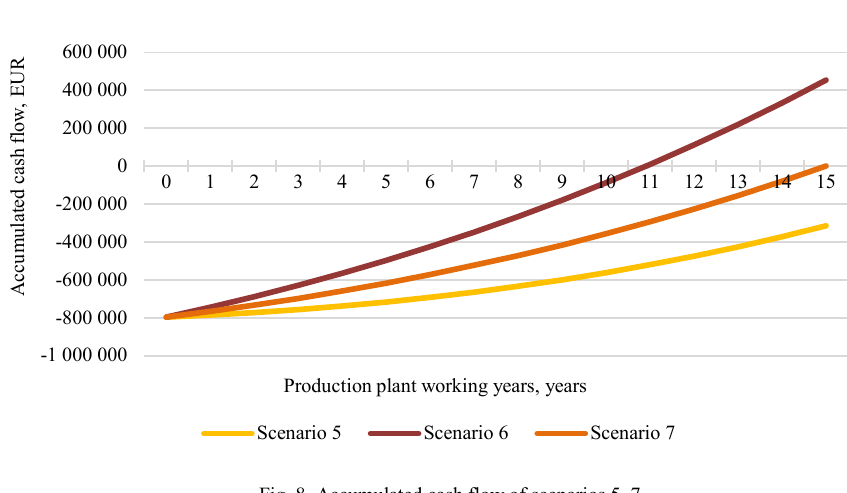
Fig. 8. Accumulated cash flow of scenarios